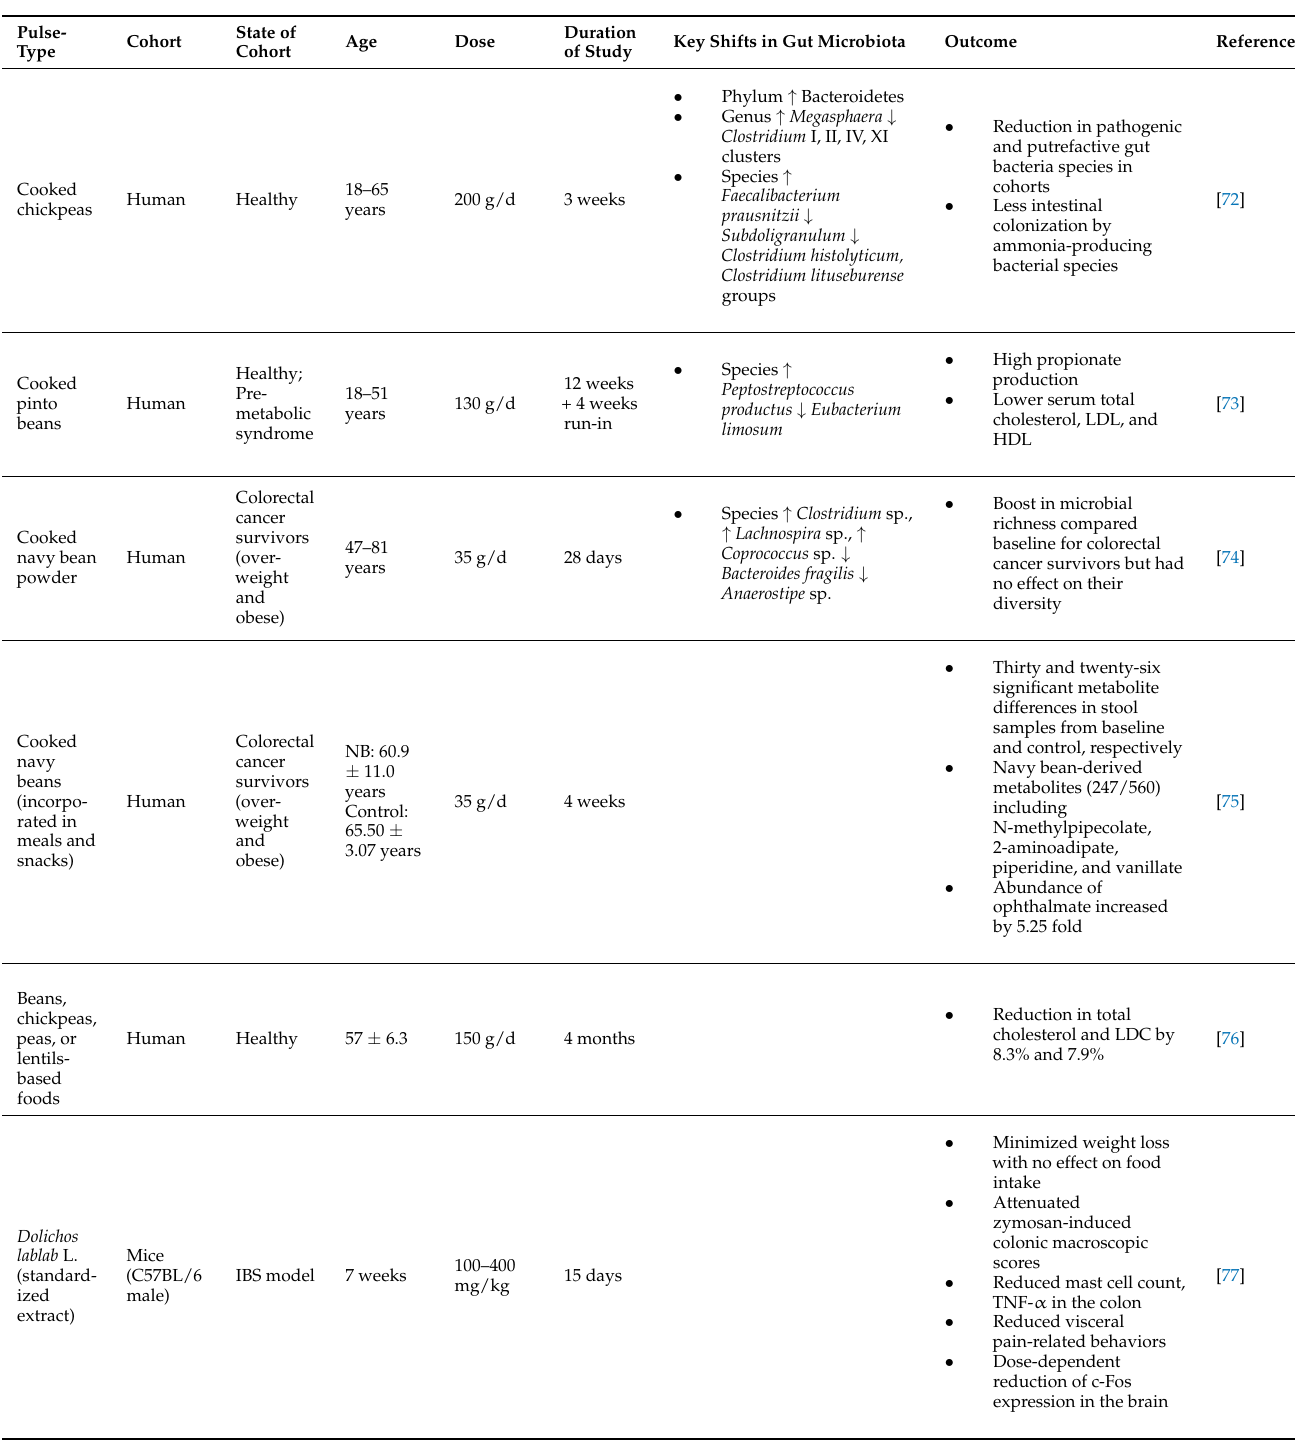
Table 1. Effect of dietary pulses on gut microbiota-related changes in rodents and